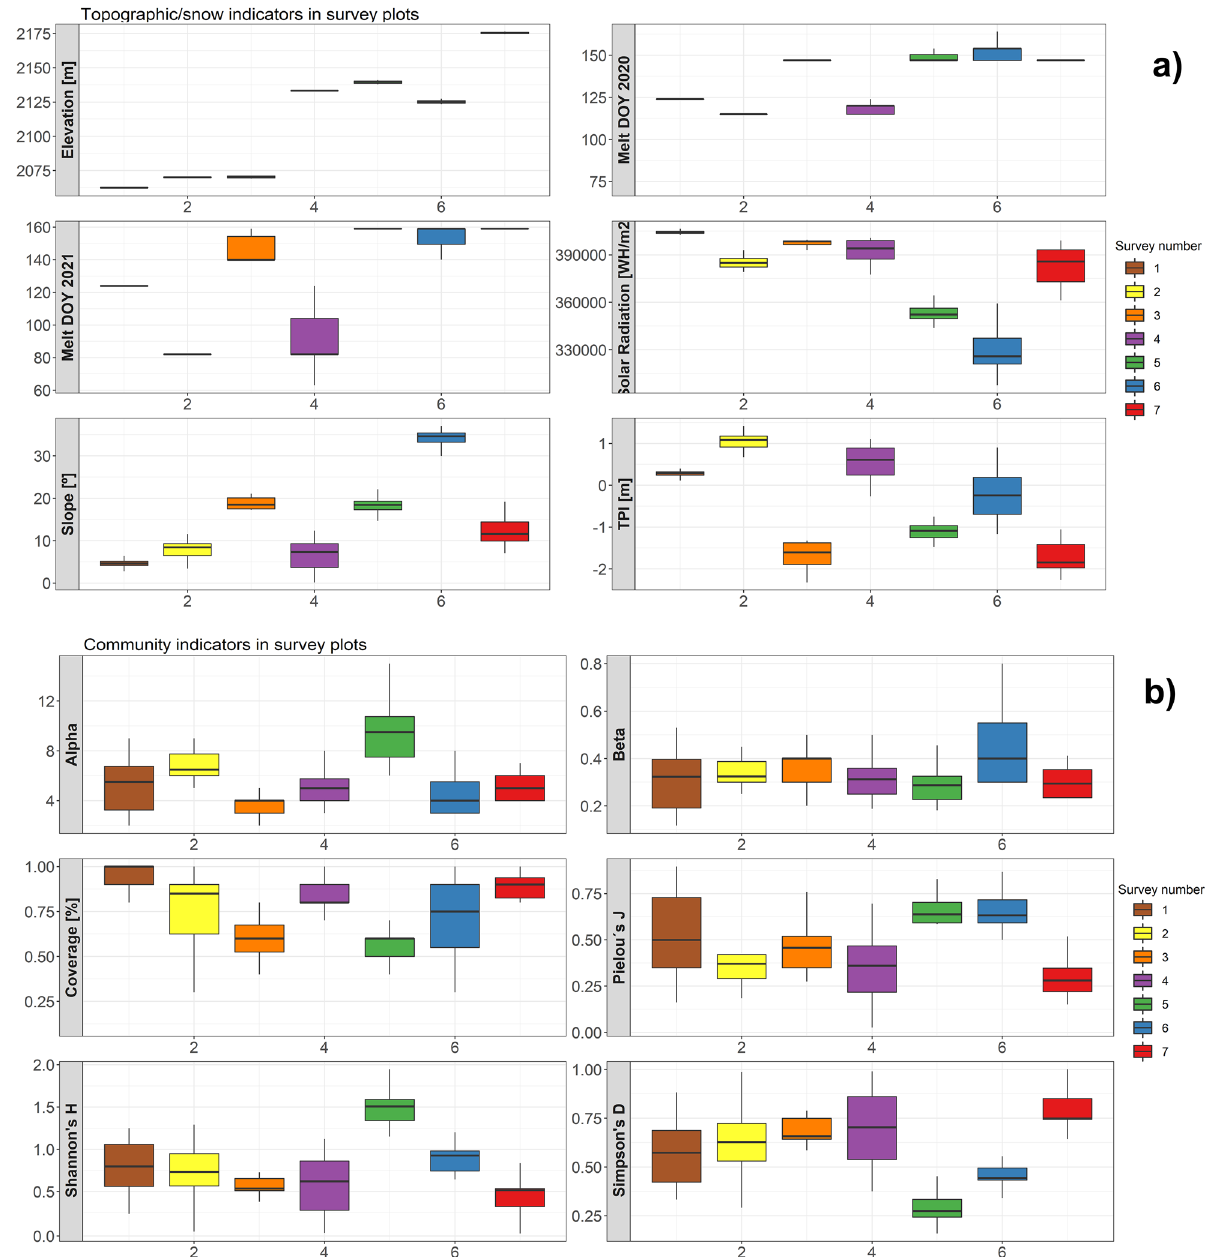
Figure 4. Box plots showing the dispersion of the topographic variables ( a ) and grassland communities’ indexes ( b ) observed at the survey plot locations. The boxes show first and third quantiles and the horizontal line inside each box the median). Whiskers include maximum and minimum values for each variable observed in the